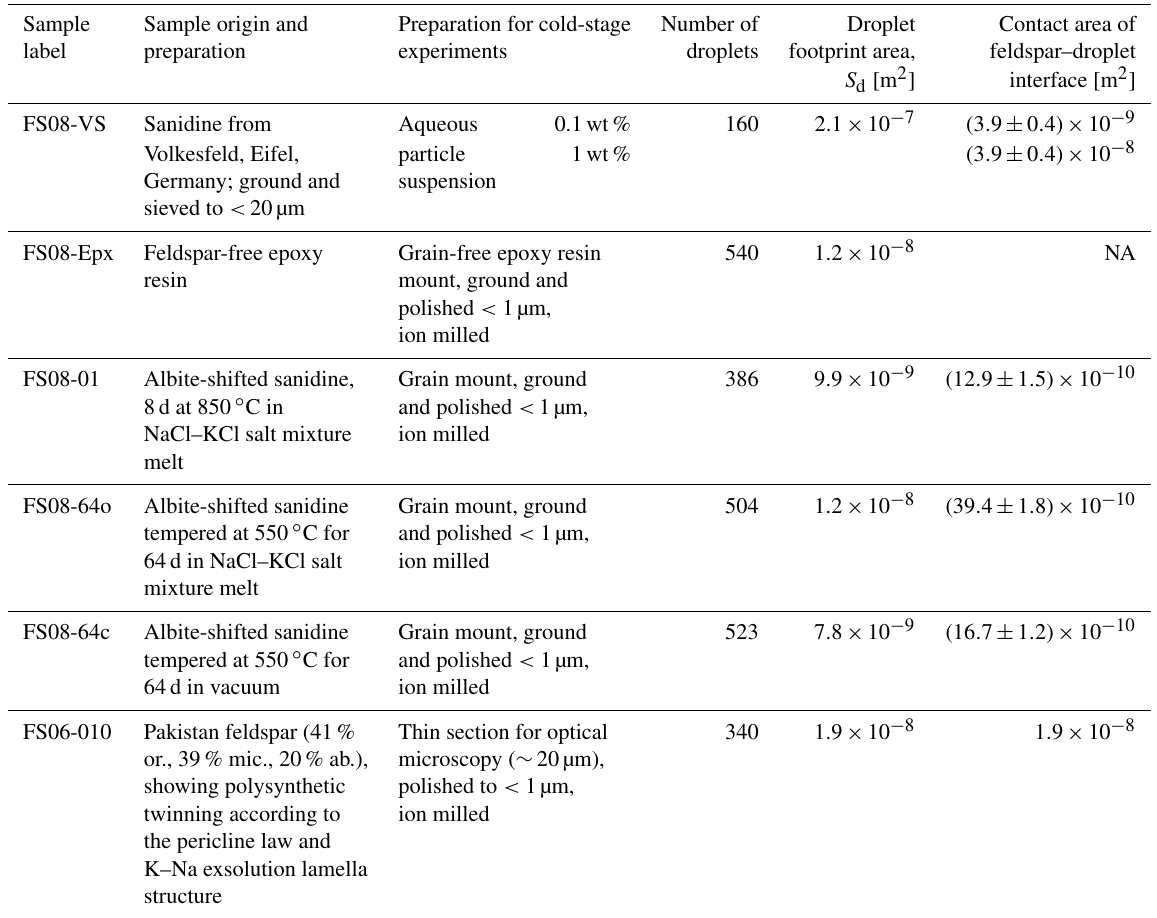
Table 1. Overview of the feldspar samples and experimental conditions. NA stands for “not applicable”. Sample Sample origin and Preparation for cold-stage Number of